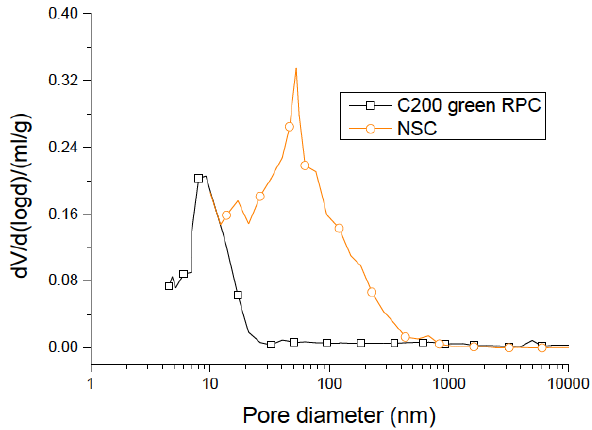
Figure 8: Differential pore size distribution